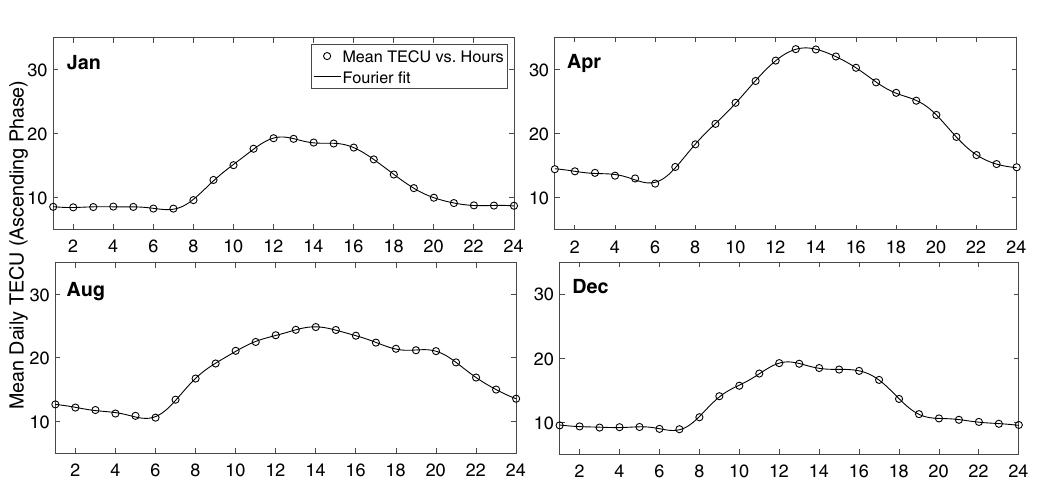
Figure 12. Seasonal variation of monthly mean normalized TEC values at different local times during the ascending phase of the solar cycle 24 (2009–2013). The continuous thick curve presents the resulted fourier series.